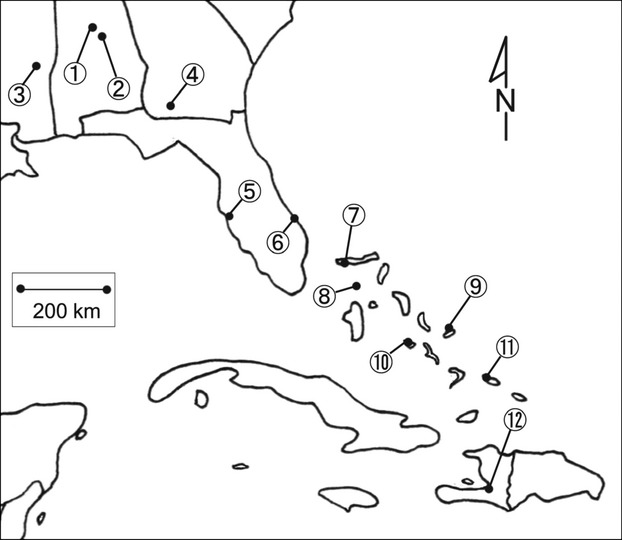
Map of locations used in postmating assays with numbers corresponding to those of Table1.